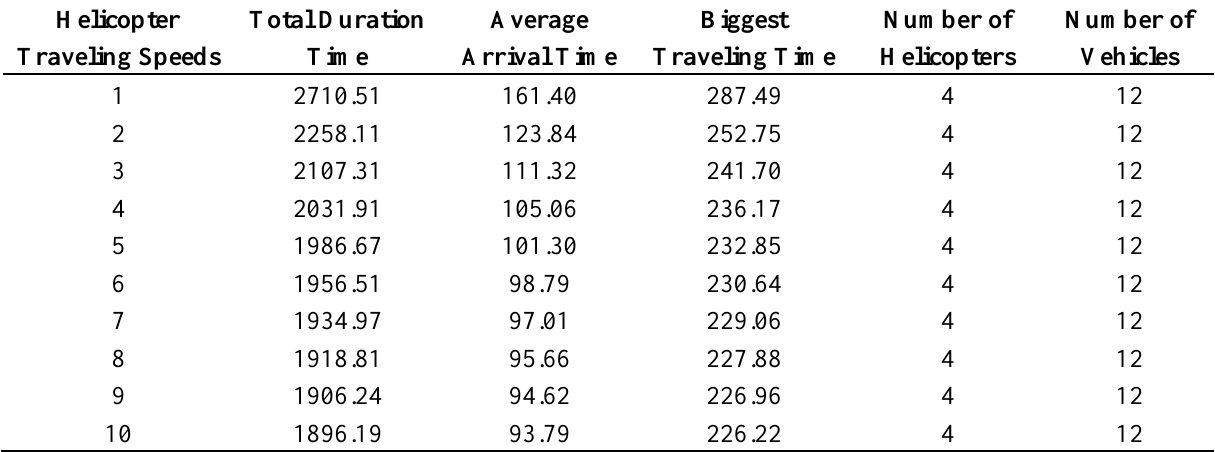
Table 5. Results with four TDCs and different helicopter travel